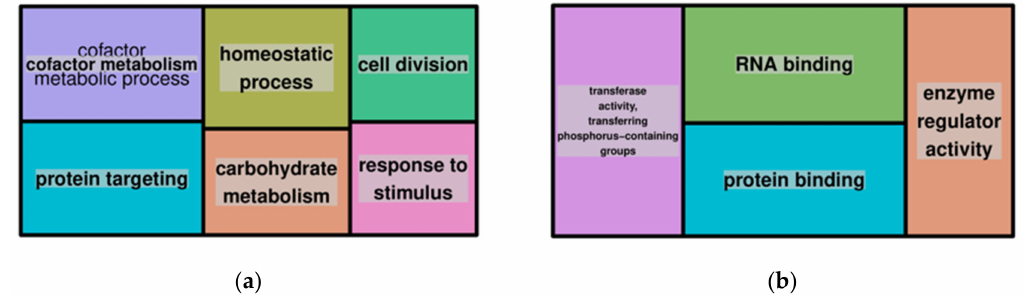
Figure 4. GO enrichment analysis for genes associated with inversions showing overrepresented GO terms, biological processes ( a ) and molecular functions ( b ). The whole genome annotations of the reference FSP34 were used as the reference set and genes within inverted regions were used as the test set.